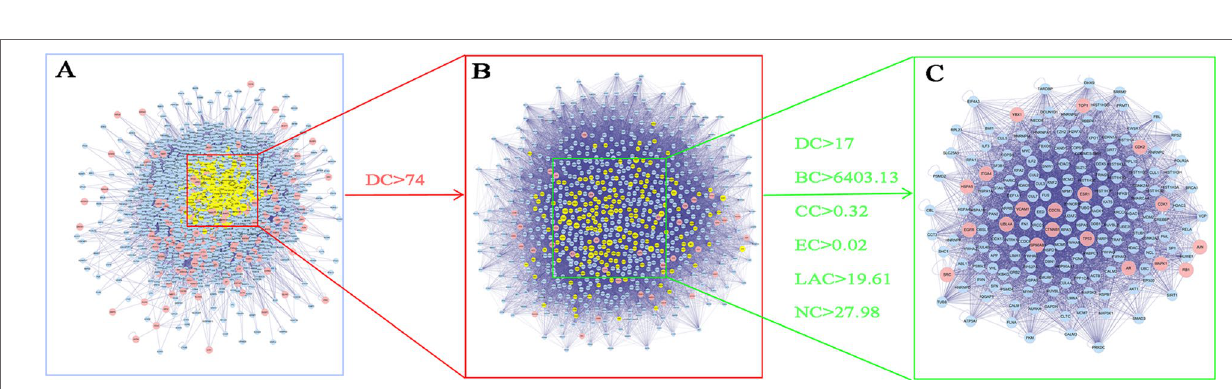
Frontiers in Pharmacology |